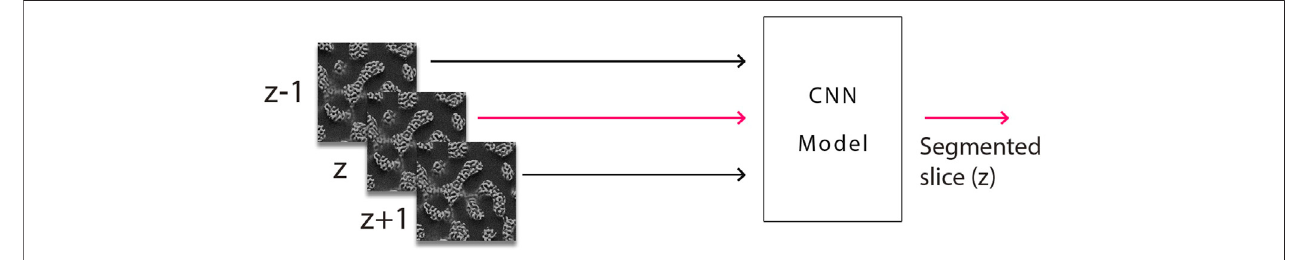
FIGURE 5 | Basic block diagram of 2D CNN receiving as input for the segmentation of slice z also the slices z − 1 (above) and z + 1 (below).